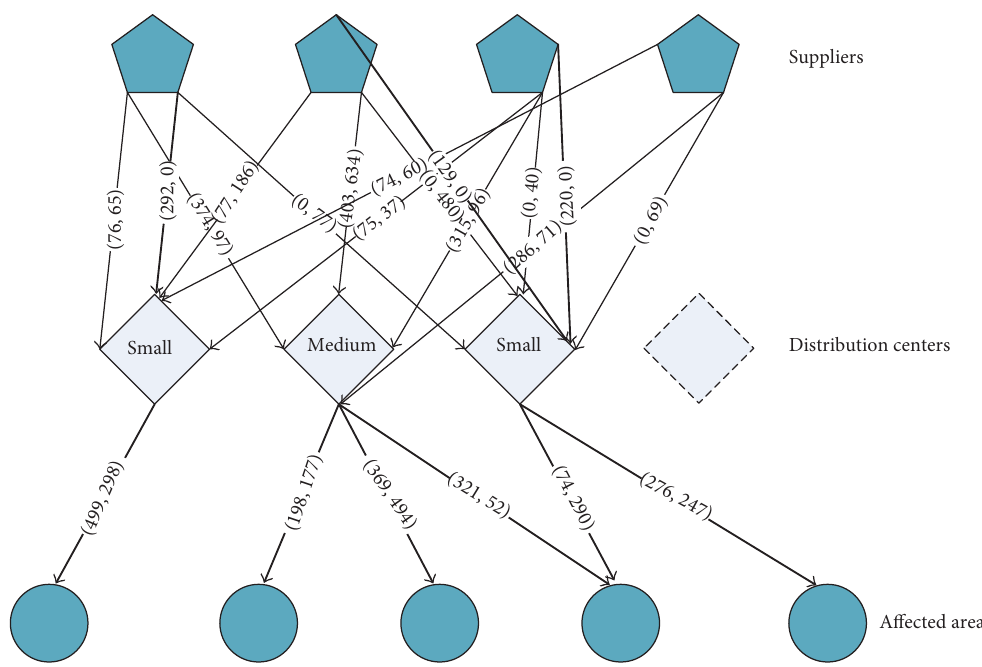
Figure 2: Solution result for prepositioning emergency supplies model.